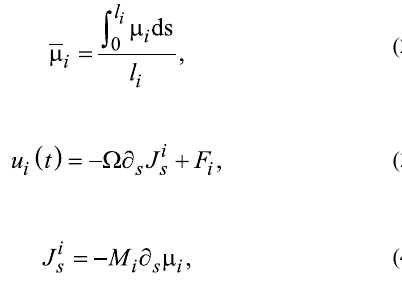
i.e., F {112} = 1.1 F {110} with F {110} being large enough. These orientations due to different sticking coefficients or exchange